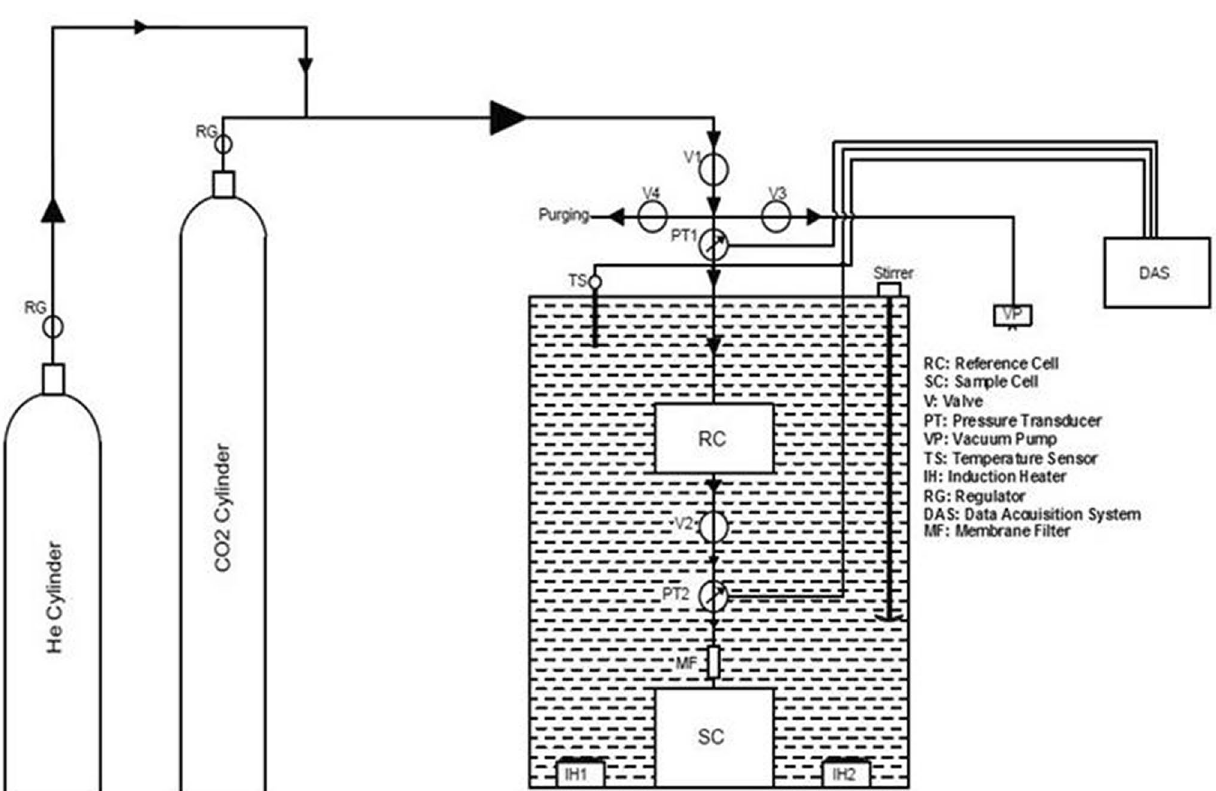
Fig. 2 Schematic diagram of volumetric sorption